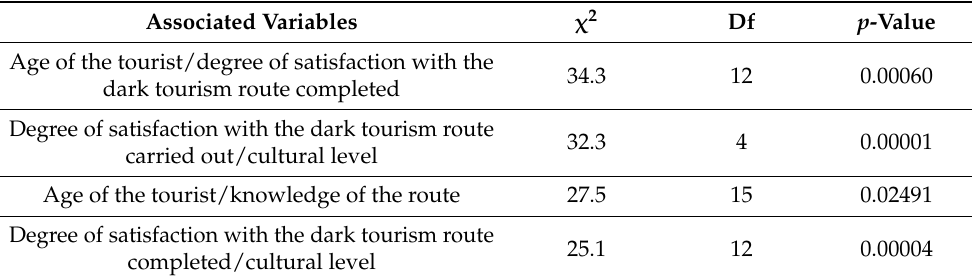
Table 6. Results of the bivariate analysis of the demand for dark tourism in C ó rdoba. Associated Variables χ 2 Df p -Value dark tourism route completed